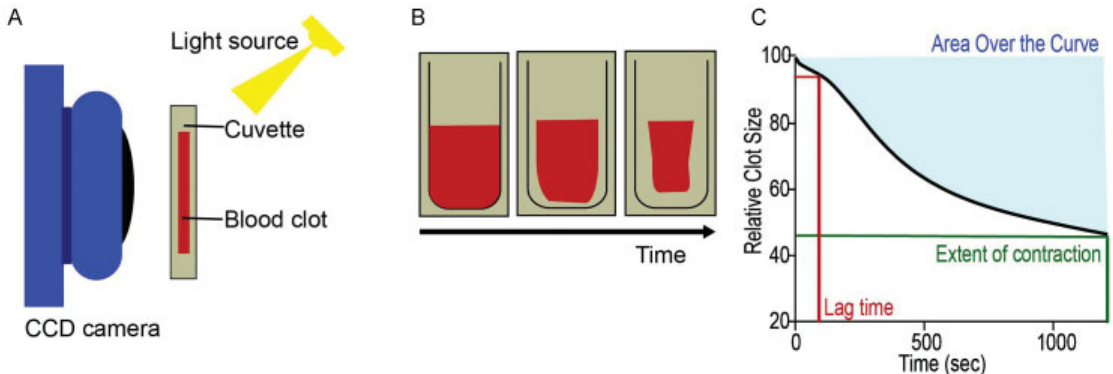
Fig.1 Schematicofexperimental methods. ( A ) Recalci fi edwholeblood sampleswith thrombinwereadded to a cuvetteandallowedto contract. Images were recorded by a charge-coupled device camera every 15 seconds based on the light scattering properties of the clot versus the expelled serum. ( B , C ) Data on relative clot size were recorded over time, where the original kinetic curve could be analyzed for the extent of clot contraction (green) at 20 minutes, the lag time (red) or the time to 5% contraction, or the area over the curve (blue), representing the workdone by the contracting